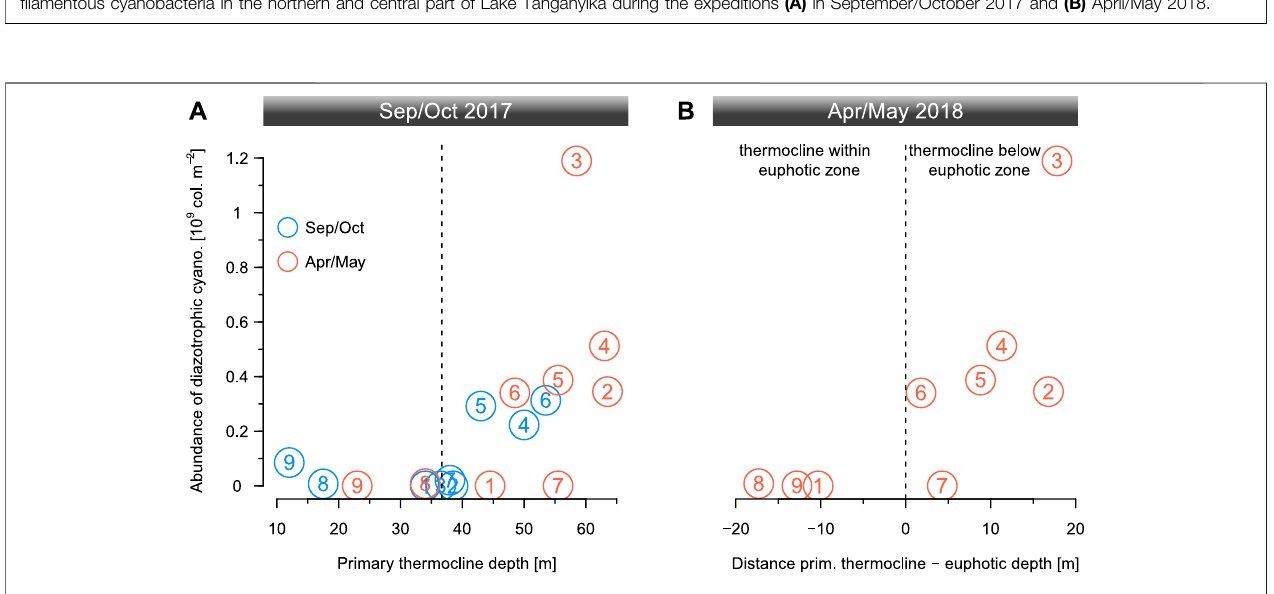
FIGURE 5 | The depth-integrated abundance of diazotrophic cyanobacteria colonies for the 9 sampling stations plotted (A) as a function of primary thermocline depth for the end of the dry season (September/October 2017) and the end of the rainy season (April/May 2018) and (B) against the distance between euphotic depth and primary thermocline location for the warm season (irradiance data for Sep/Oct missing). In Sep/Oct, the diazotrophic cyanobacteria abundances were high if the thermoclinewaslocatedbelow40 m.Abreakpointanalysisidenti fi ed36.7 masbreakpointlocationintherelationshipbetweenthesetwovariables.InApr/May,the abundances of diazotrophic cyanobacteria were high if the thermocline was located below the euphotic zone.